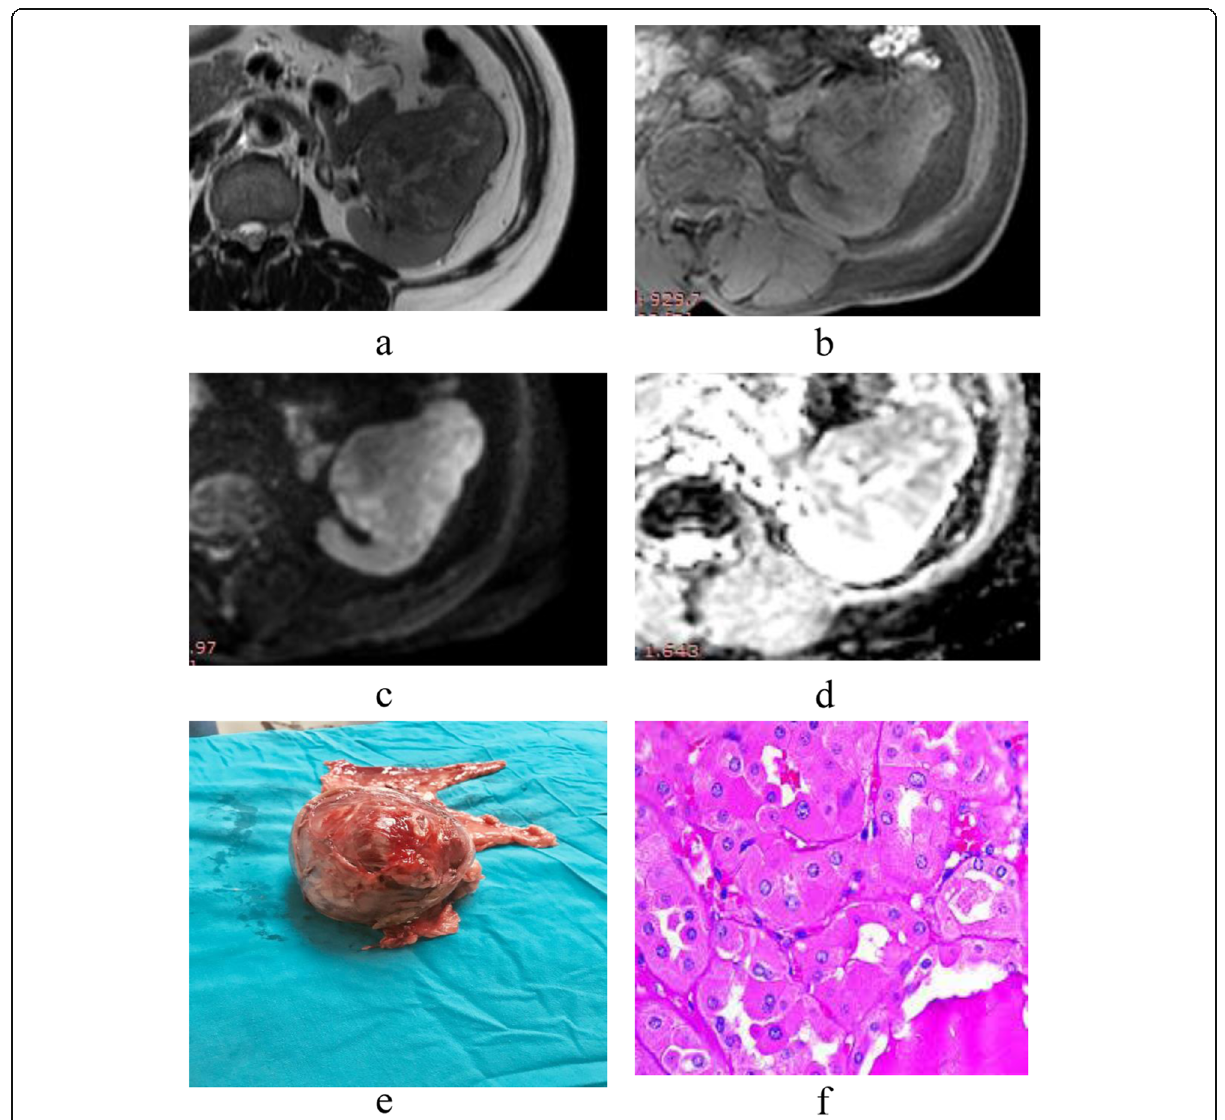
Fig. 9 A 50-year-old female coming with left loin pain a T2 WI showing a hypointense left renal mass with central scar, b T1WI iso to hypointense, c , d DWI with ADC showing restricted diffusion; ADC = 1.18 × 10 − 3 mm 2 /s, e gross surgical specimen after partial nephrectomy,